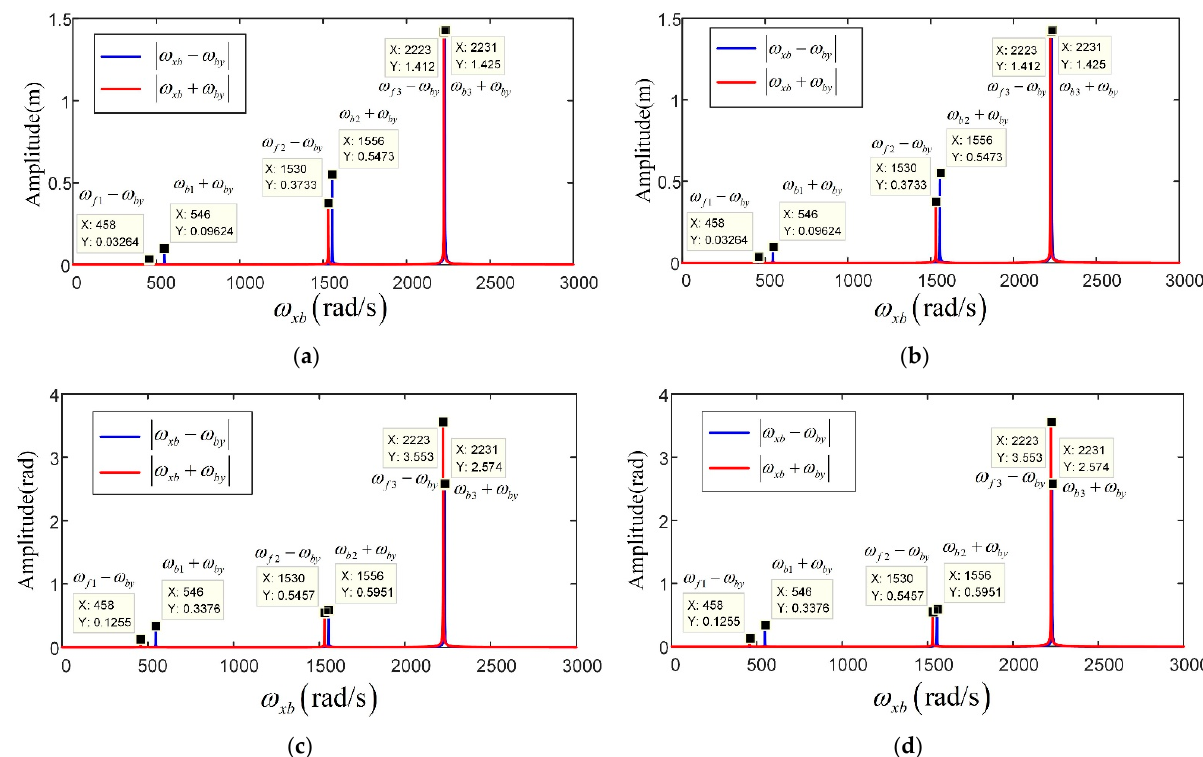
Figure 9. Responses of the counter-rotating dual-rotor system under harmonic base translations and constant pitching base motion: ( a ) x d 1 ; ( b ) z d 1 ; ( c ) θ d 1 ; ( d ) ψ d 1 .